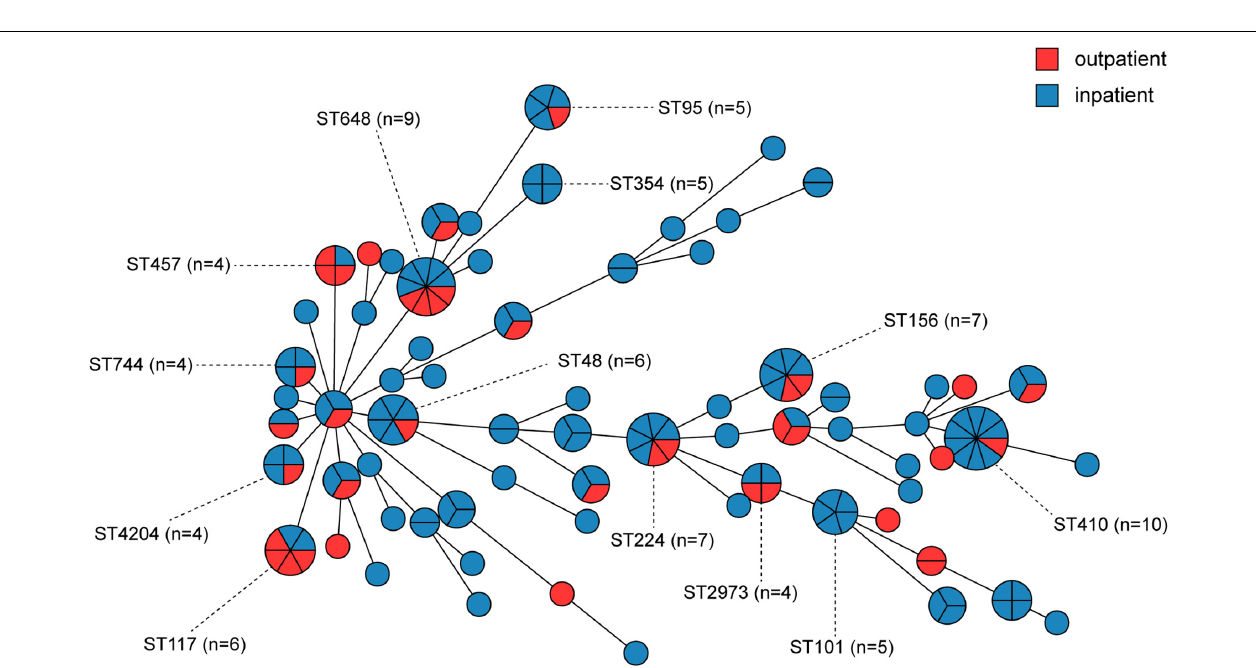
FIGURE 3 | Distribution of Inc type, ARGs, heavy metal genes, and VAGs among MCRPEC isolates. The color of each box represents the percentage of the corresponding item among sequenced isolates in the corresponding year. ARGs, antibiotic resistance genes; HMGs, heavy metal genes; VAGs, virulence-associated genes.